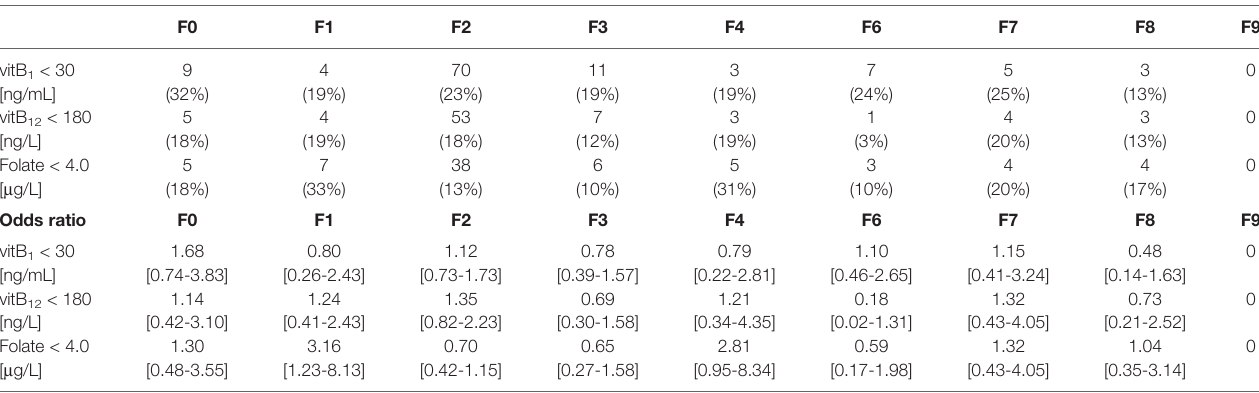
TABLE 2 | Vitamin B de fi ciencies in sub-groups.